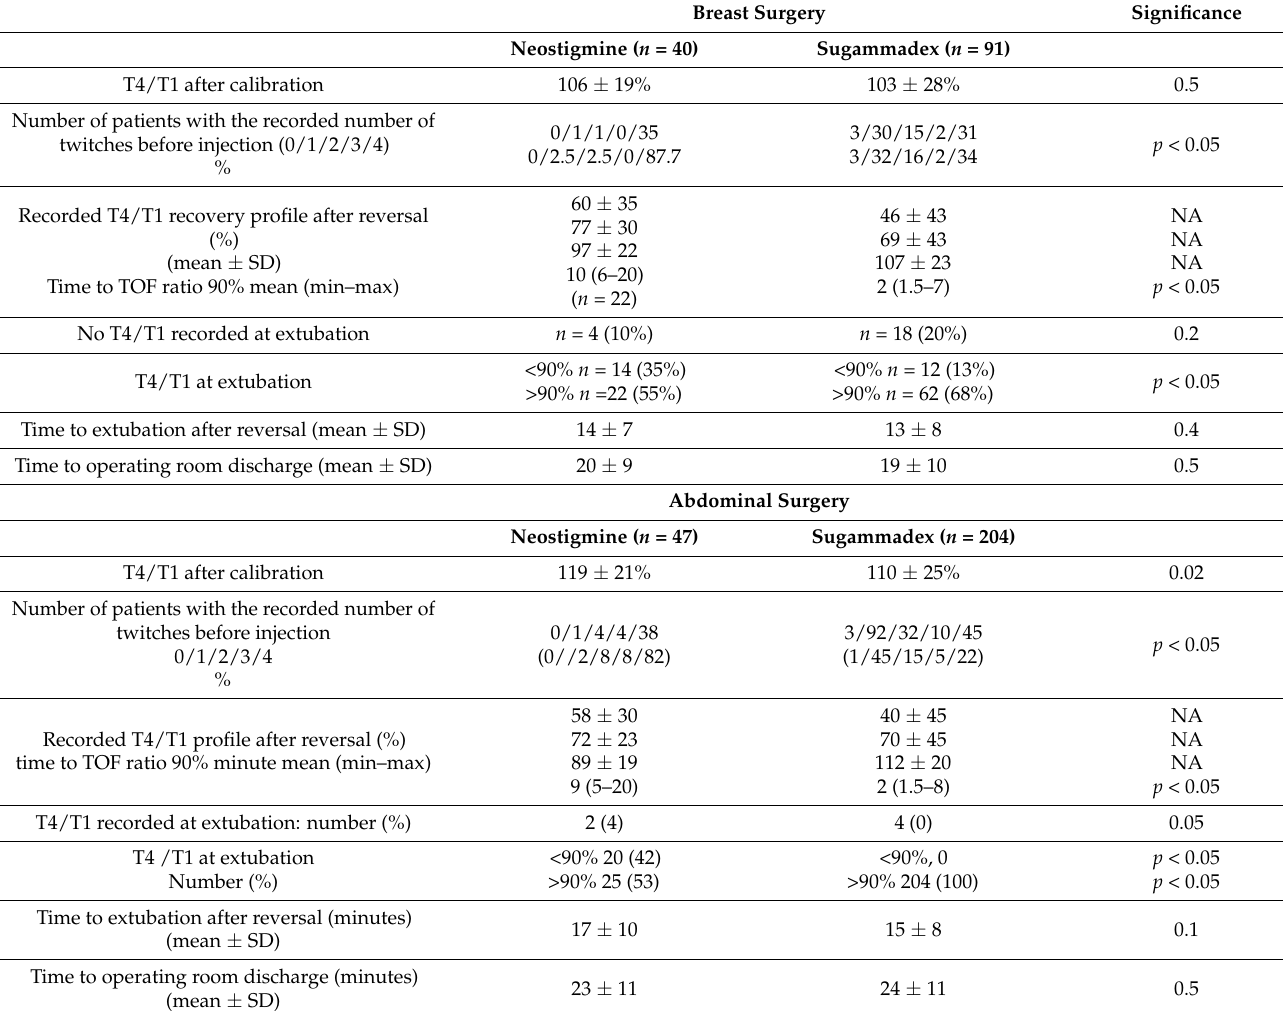
Table 3. Neuromuscular monitoring characteristics for